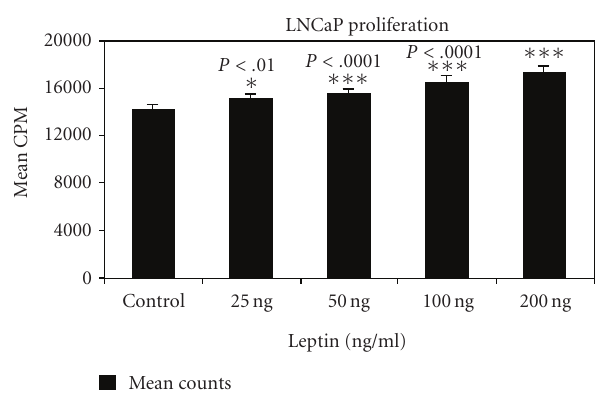
Figure 2: Proliferation of androgen-dependent prostate cancer cells is induced by leptin. Growth factor starved LNCaP cells were incubated with increasing concentrations of leptin, and proliferation was measured by the incorporation of [ 3 H]thymidine after 144 hours. Values represent the mean ± S.E. of triplicate samples of a representative